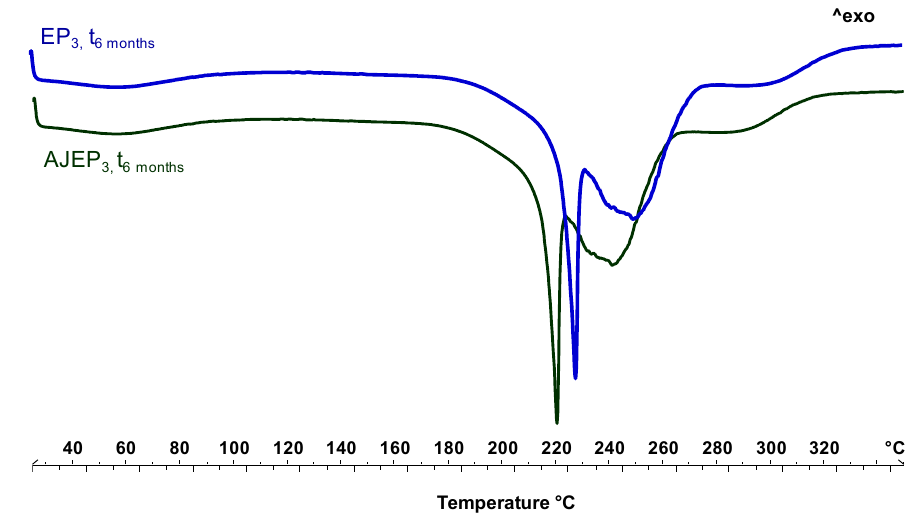
Figure 9. Dimensional distribution analysis (by Laser Light Scattering (LLS)) of AJEP 3 after six months (t 6months ) of harsh storage conditions.